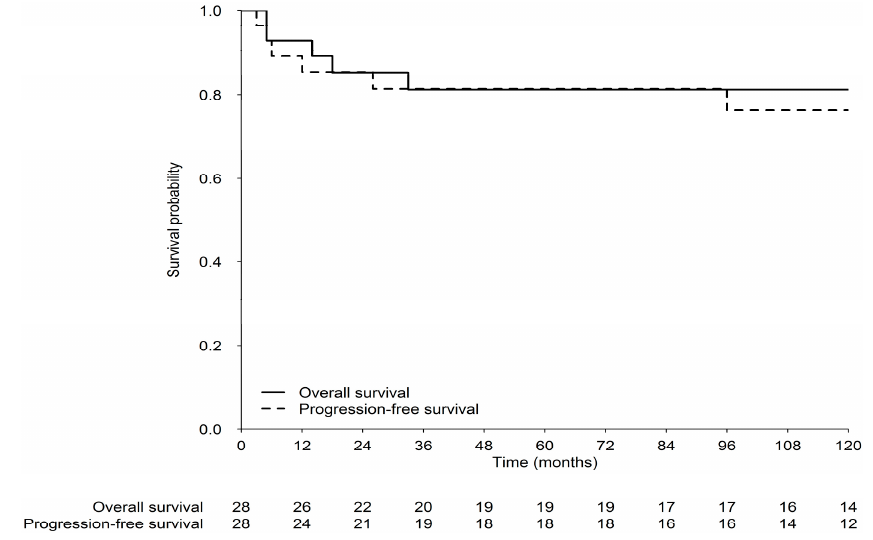
Figure 2. Overall survival (OS) and progression-free survival (PFS) of the whole series.